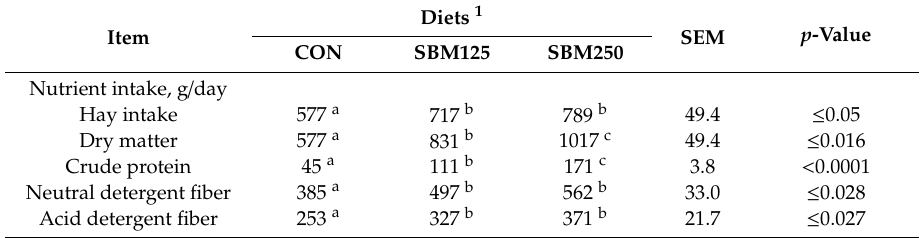
Table 1. E ff ect of protein supplementation on nutrient intake of Awassi lambs fed low-quality forages.